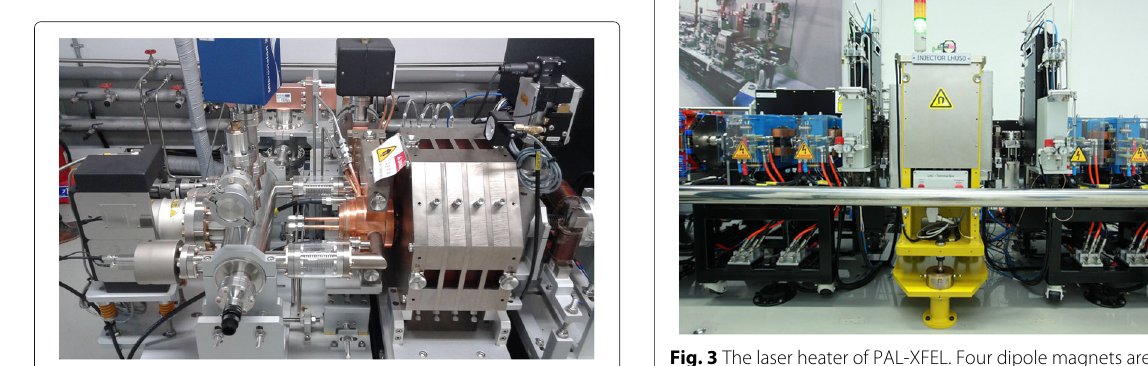
Fig. 2 The photocathode RF gun of PAL-XFEL